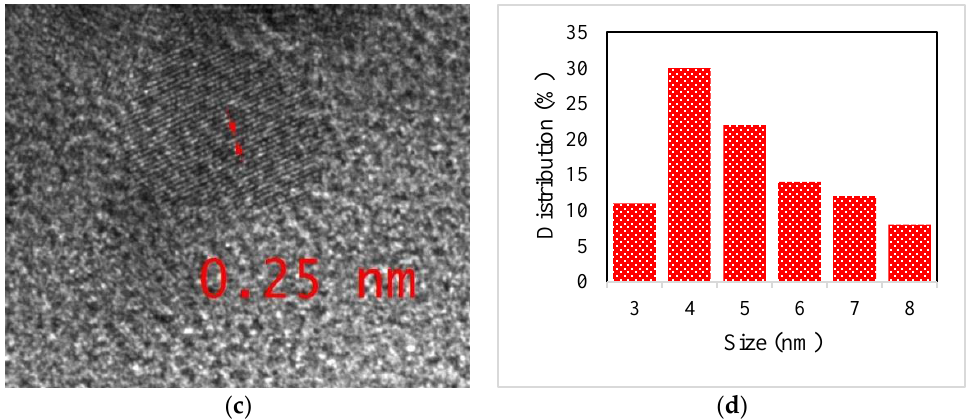
Figure 1. TEM images of the N–CDs in different magnifications ( a , b ), high-resolution (HR)TEM image ( c ) and the histogram showing the distribution particle size ( d ).